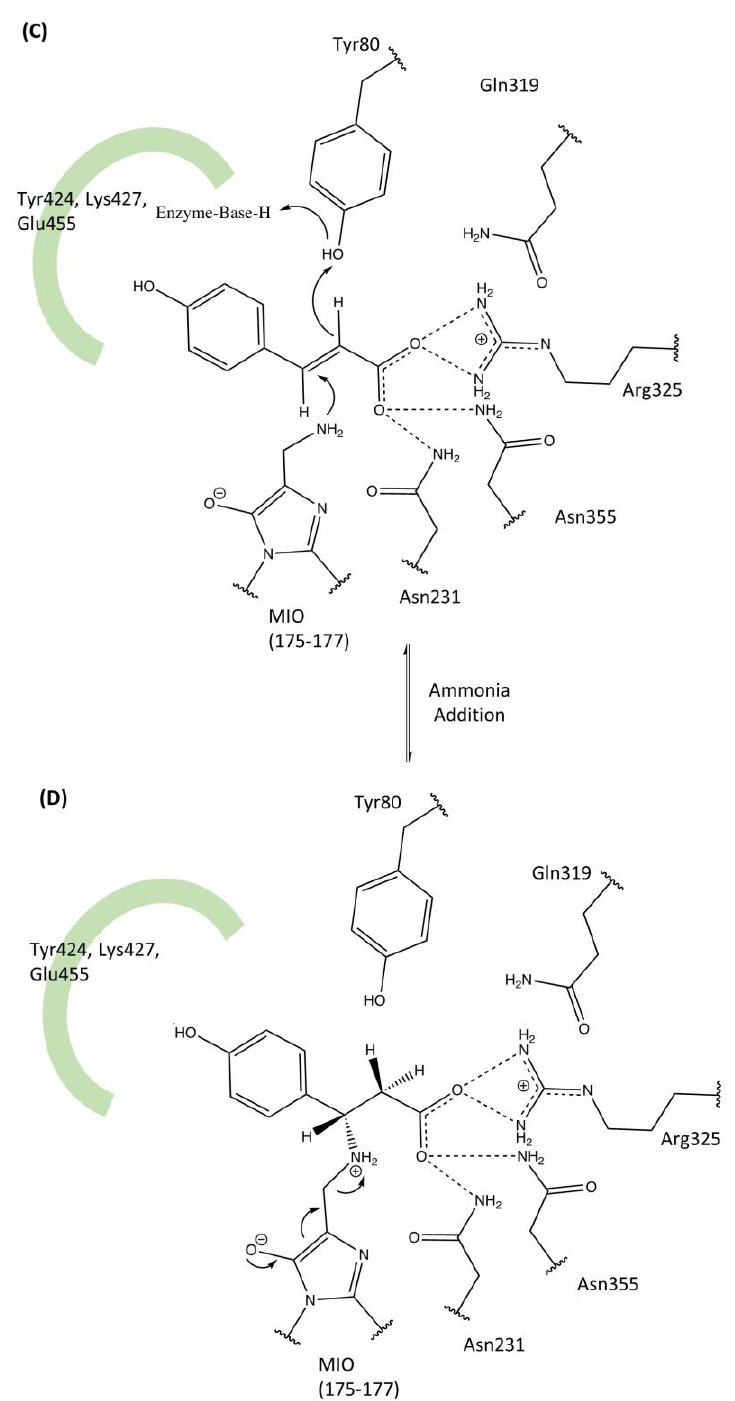
Figure 5. The proposed reaction mechanism for TchPAM during the ammonia addition of ( S )- α -tyrosine and ( R )- β -tyrosine in mutant Tyr424Asn as an example. ( A ) The binding mode I when trans - p -hydroxycinnamic acid enters the active site as substrate. ( B ) The ammonia addition on trans - p -hydroxycinnamic acid in the binding mode I to yield ( S )- α -tyrosine. ( C ) The binding mode II when trans - p -hydroxycinnamic acid enters the active site as the substrate. ( D ) The ammonia addition on trans - p -hydroxycinnamic in the binding mode II to yield ( R )- β -tyrosine. This hypothesis was backed up by the measurement of the conversion and the enantiomeric excess of the designed enzymes in ammonia addition reaction of trans - p - hydroxycinnamic acid, monitored by High-performance liquid chromatography